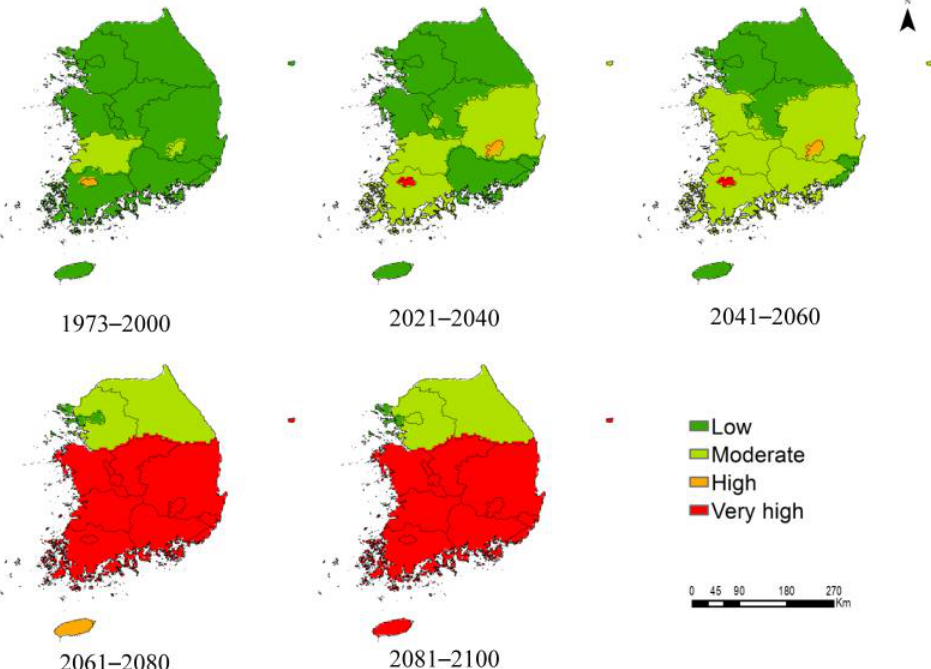
Figure 6. Mean habitat suitability for P. hysterophorus in different ADs of South Korea under the current climate (1973 – 2000) and future climate scenarios (SSP5-8.5; 2021 – 2040, 2041 – 2060, 2061-2080, and 2081 – 2100). Mean habitat suitability was classified into four categories (low, moderate, high, and very high), each of which is indicated with a different